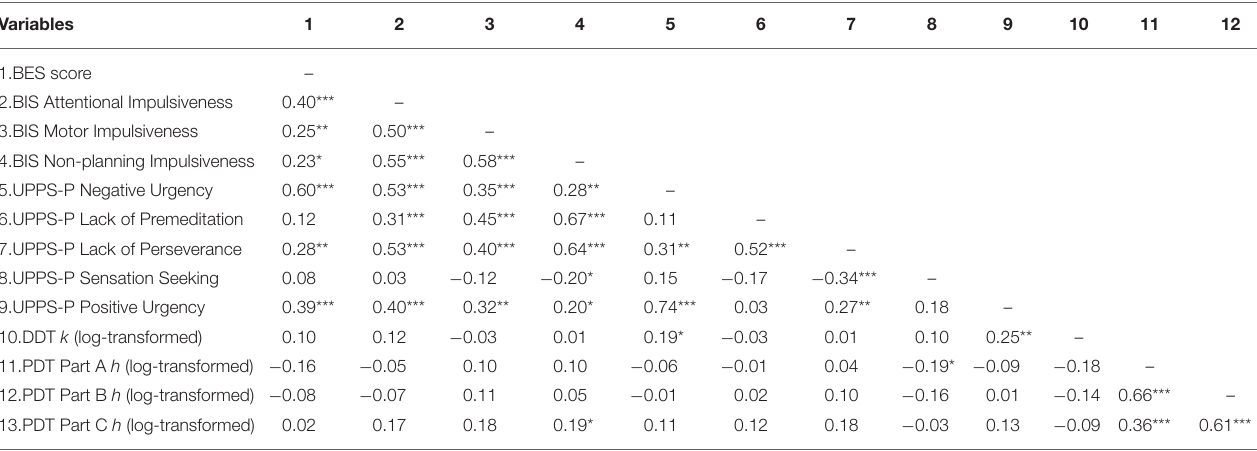
TABLE 2 | Partial correlations analyses of impulsivity measures and BES scores ( N = 117). Variables